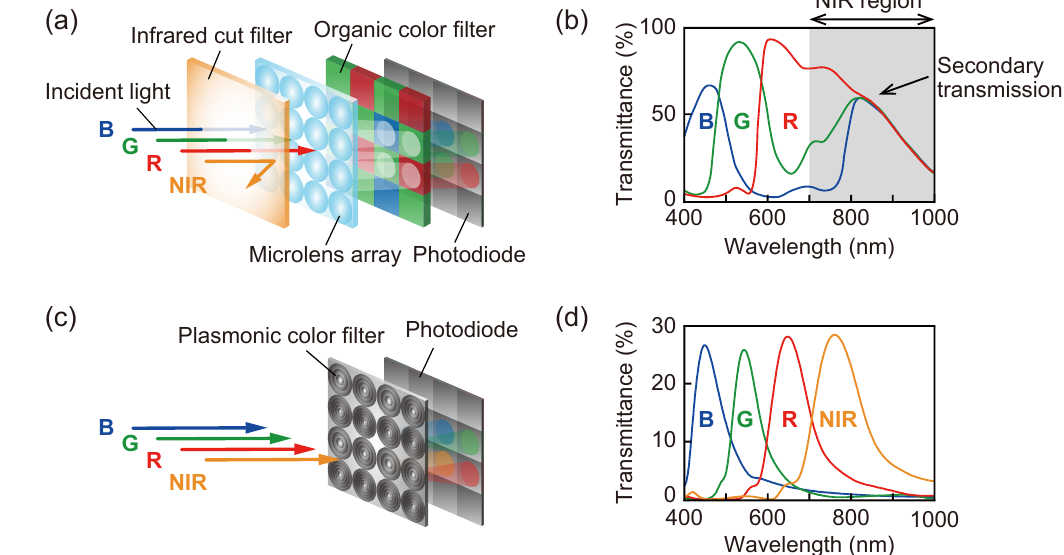
Figure 2. ( a )Thegeneralpixelconfigurationbyusingorganiccolorfiltersand( b )thetypicalRGBtransmission spectra of organic color filters. ( c ) A schematic of the proposed configuration and ( d ) the corresponding simulated RGB–near-infrared (NIR) transmission spectra showing the selectivity of the